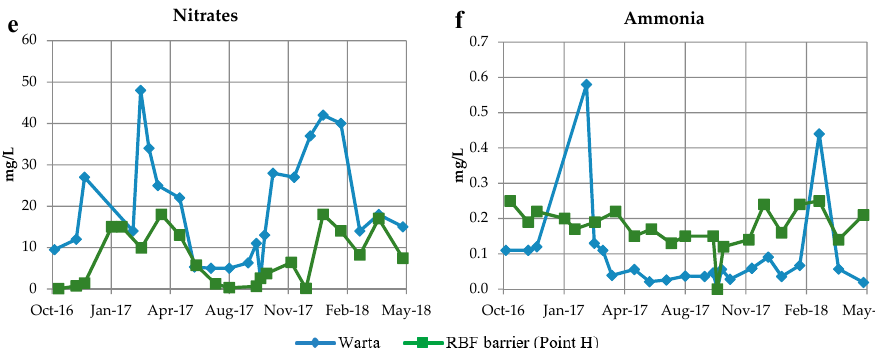
Figure 4. Temporal changes of selected parameters in bank filtrate and Warta River water. ( a ) Colour, ( b ) COD, ( c ) DOC, ( d ) coliform bacteria, ( e ) nitrates, ( f ) ammonia.